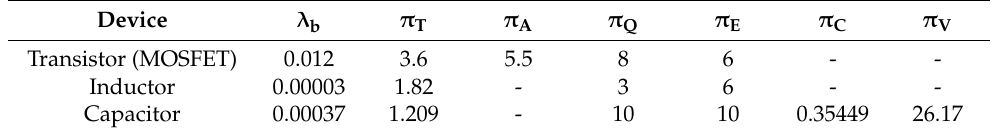
Table 4. Adjustment factors (MIL HDBK-217F standard).